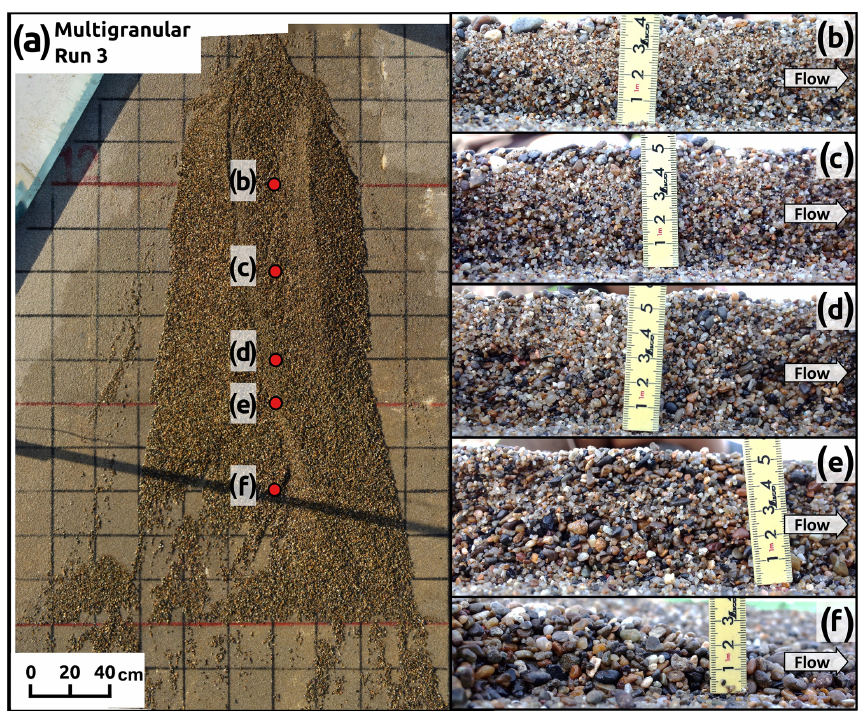
Figure 6. (a) Orthophoto of the debris-flow fan formed by the multigranular flow in test run 3. The red circles indicate the points at which the images were taken. Images of the longitudinal profile from the right-bank side view: (b) 1m downstream from the flume outlet (slope change point from 12 to 9 ◦ ), (c) 1.4m downstream from the flume outlet, (d) 1.8m downstream from the flume outlet, (e) 2m downstream from the flume outlet (slope change point from 9 to 6 ◦ ), and (f) 2.4m downstream from the flume